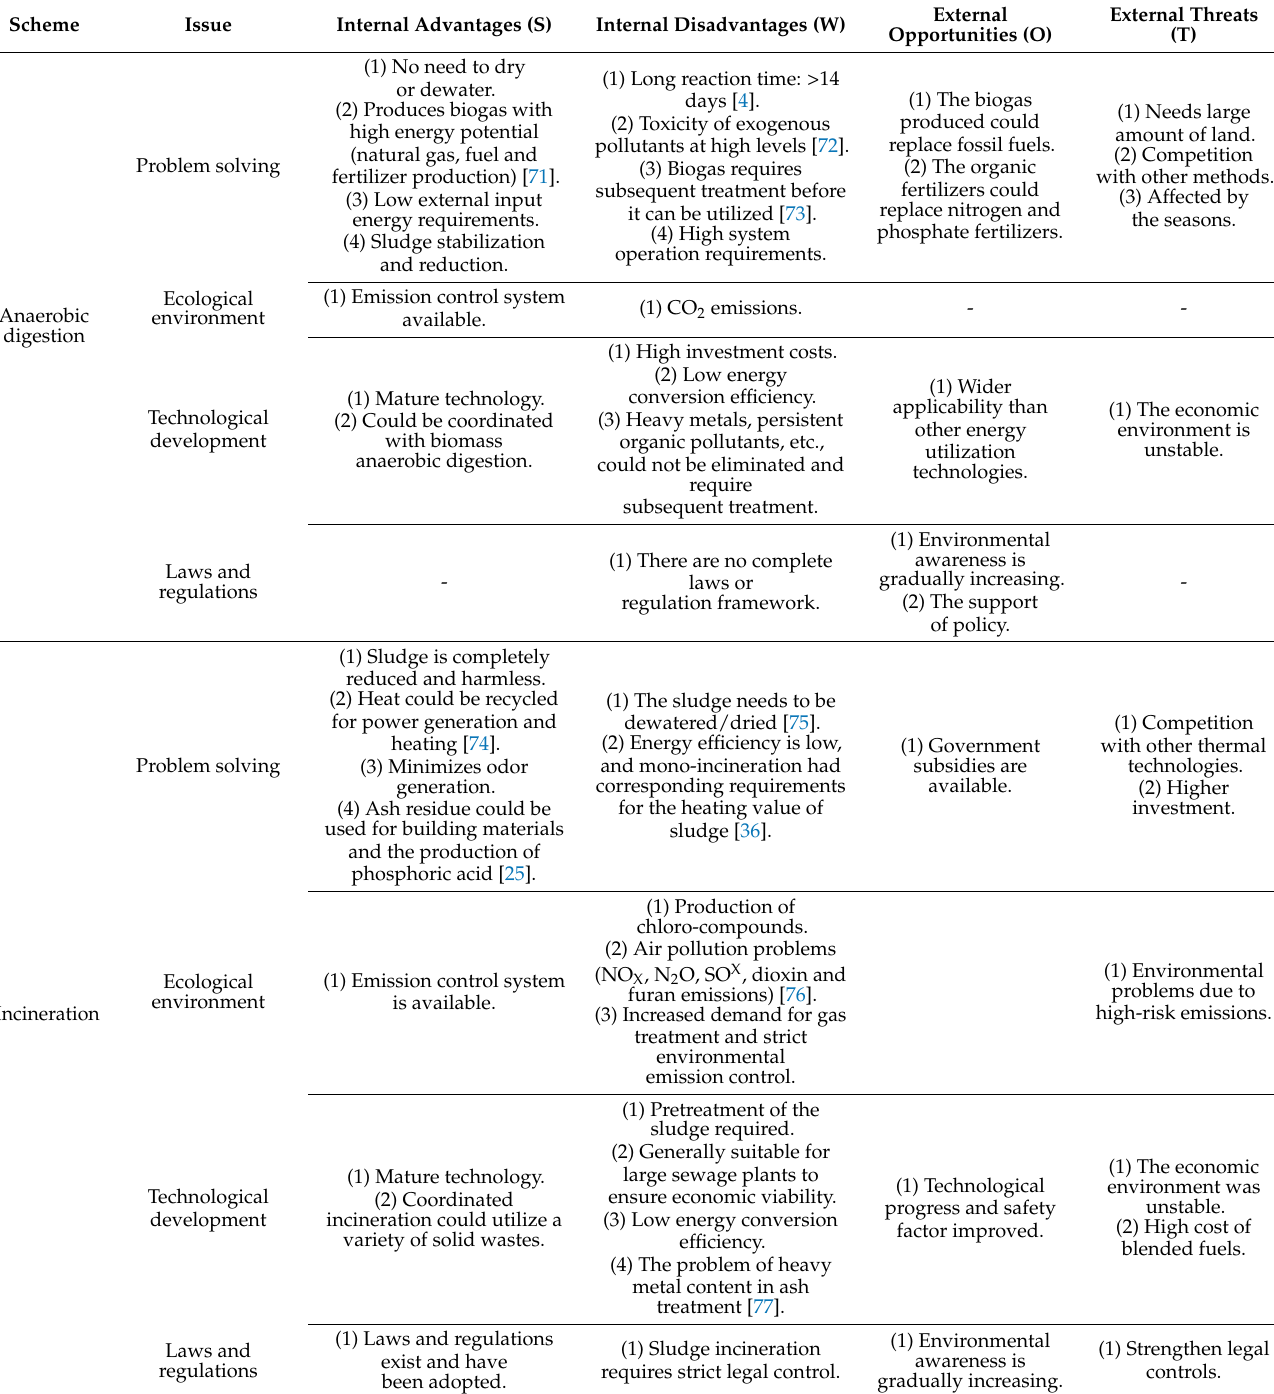
Table 1. SWOT analysis